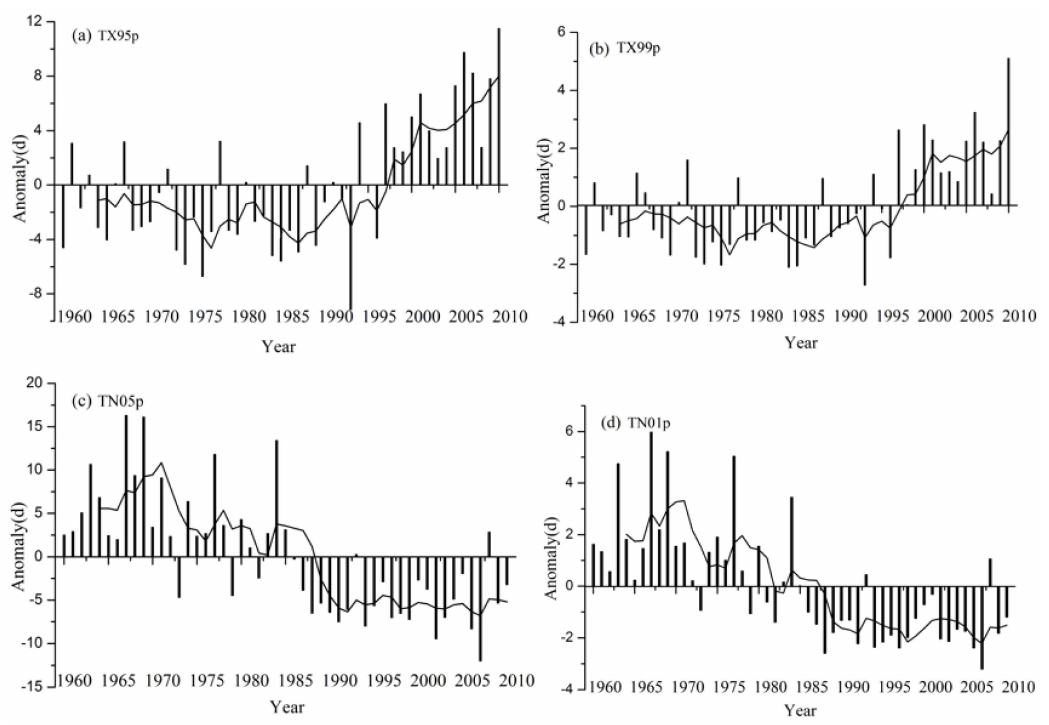
Figure 3. Anomalies in annual ( a ) warm days (TX95p); ( b ) hot days (TX99p); ( c ) cold nights (TN05p) and ( d ) very cold nights (TN01p), averaged over all the stations in mainland China during 1960-2010. The anomalies are relative to the 1971–2000 mean values. The curve fitting used a 5-year moving average smoothing method.